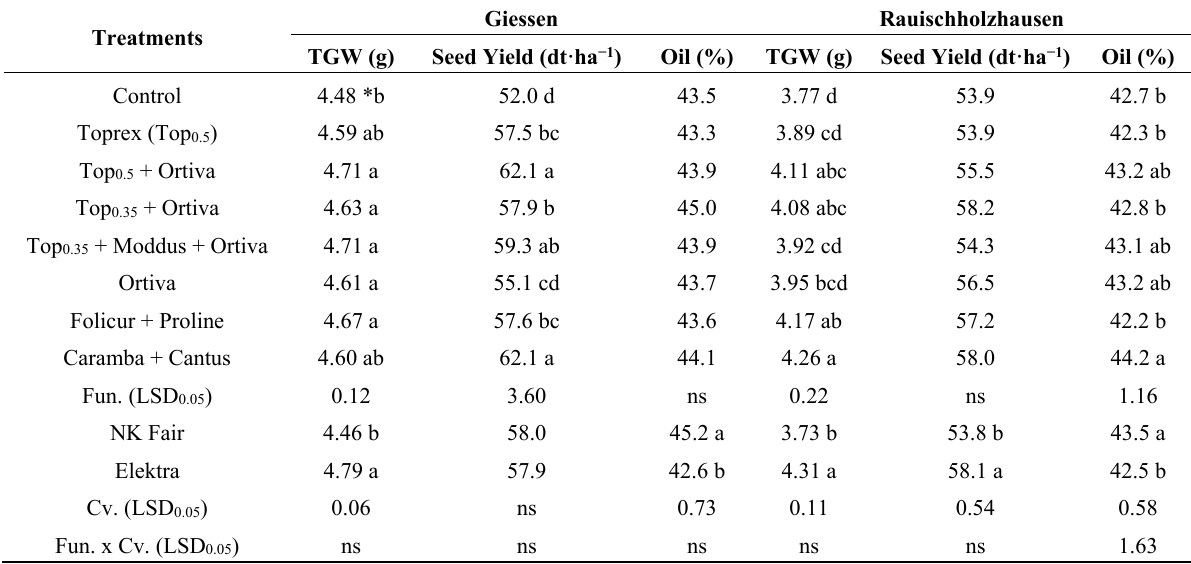
Table 3. Effect of fungicides and growth regulator on TGW, seed yield, and oil content of two cultivars of winter rapeseed at GI and RH. Giessen Rauischholzhausen Treatments TGW